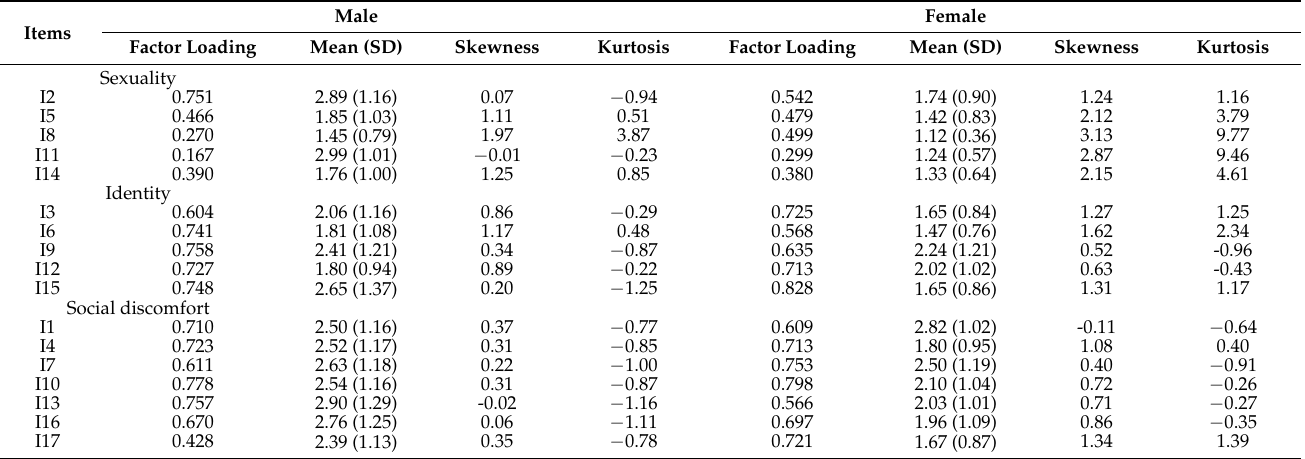
Table 2. Confirmatory factor analysis results and item properties for the Measure of Internalized Sexual Stigma for Lesbians and Gay Men (MISS-LG). Items Factor Loading